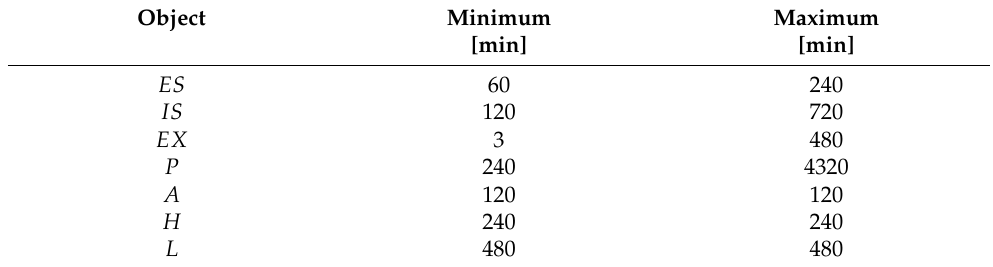
Table 3. Expected recovery